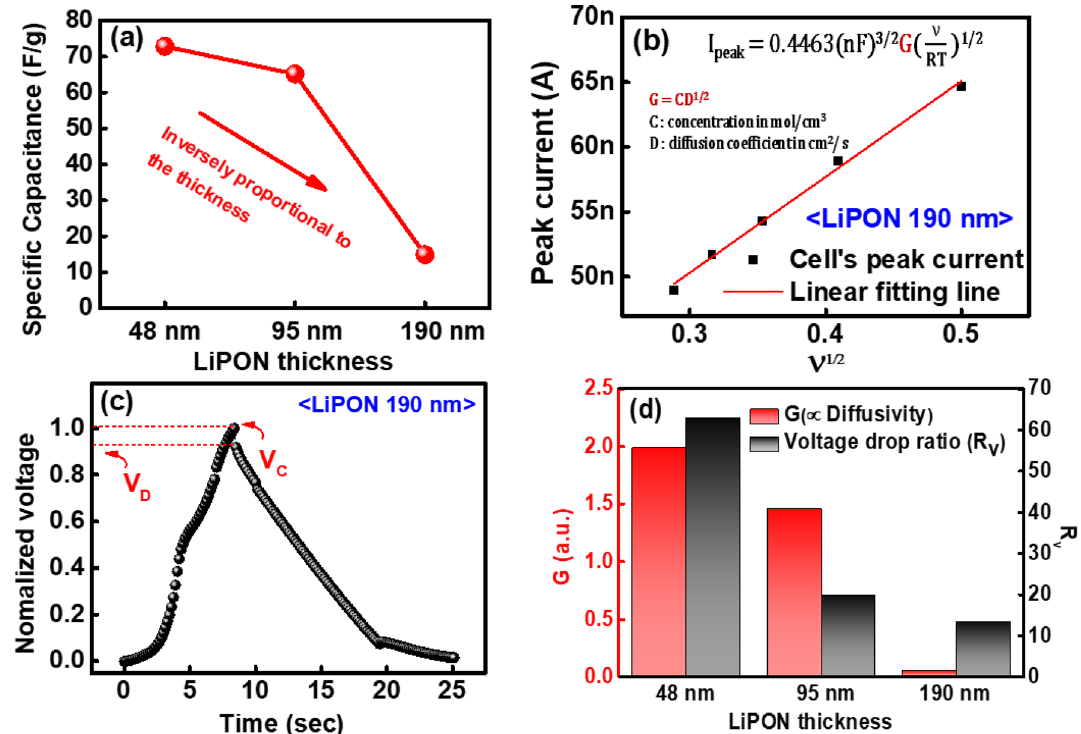
Figure 3. ( a ) Specific capacitance depending on the LiPON thickness. ( b ) Peak current (I peak )—scan rate ( √ ν ) curve for various ν , and ( c ) galvanostatic charge discharge curve of LiPON 190 nm T-SC device. ( d ) G (CD and voltage drop ratio (R v ) for different LiPON